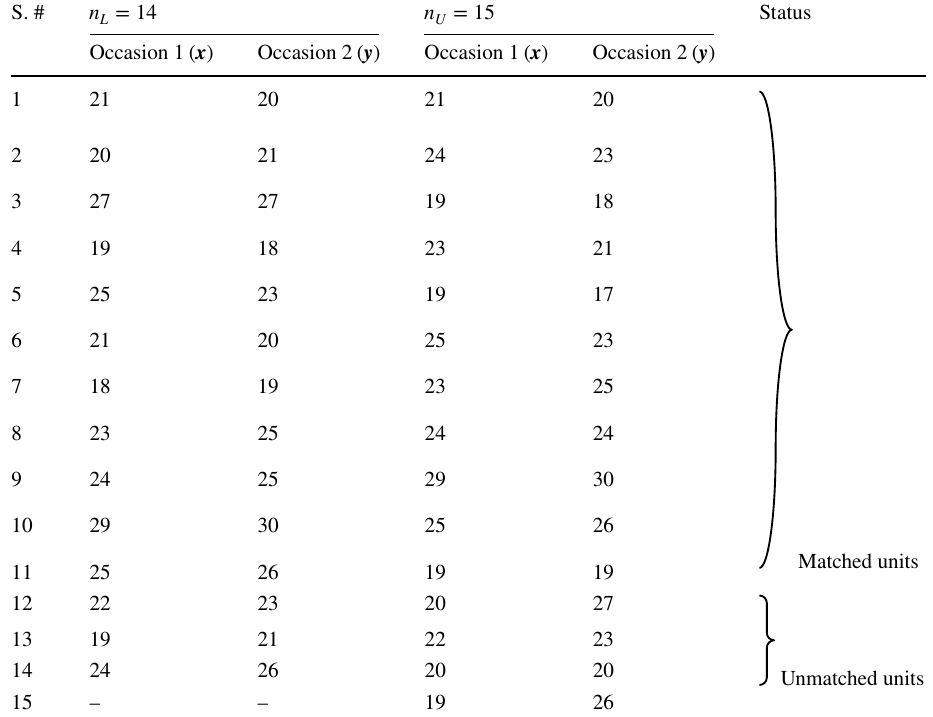
Table 13 Sampling procedure over two successive